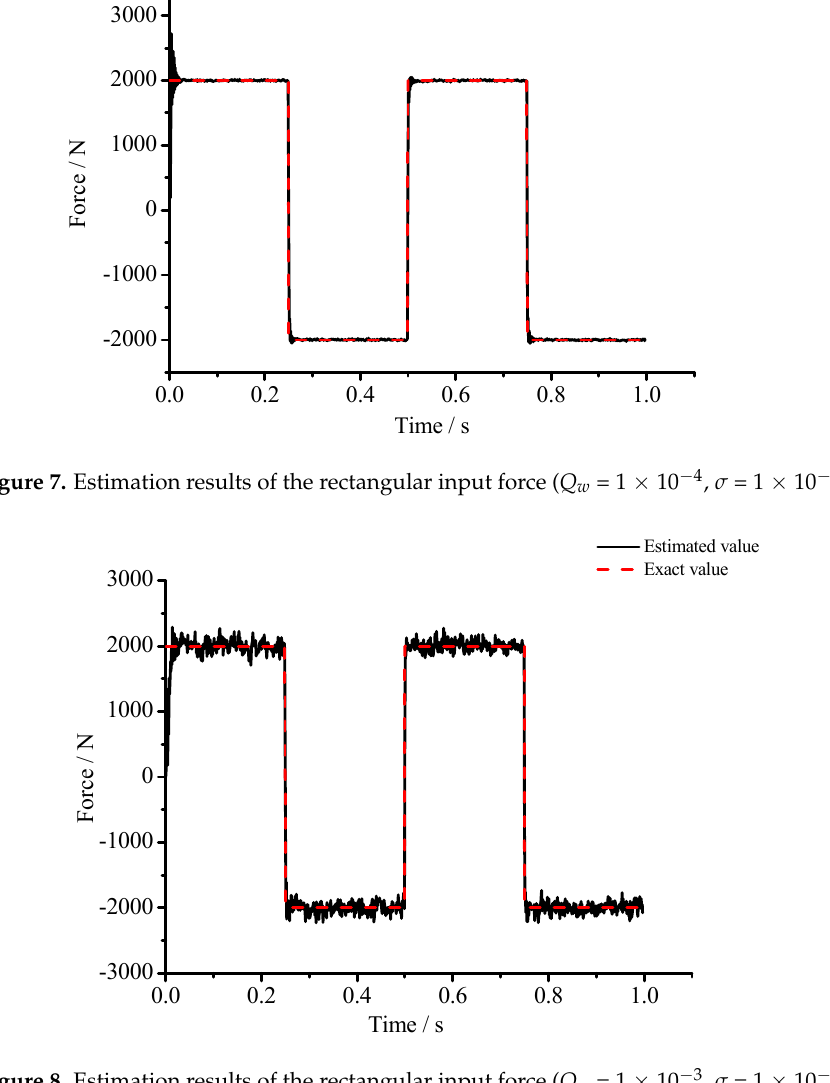
Figure 8. Estimation results of the rectangular input force ( Q w = 1 × 10 − 3 , σ = 1 × 10 − 6 ) .